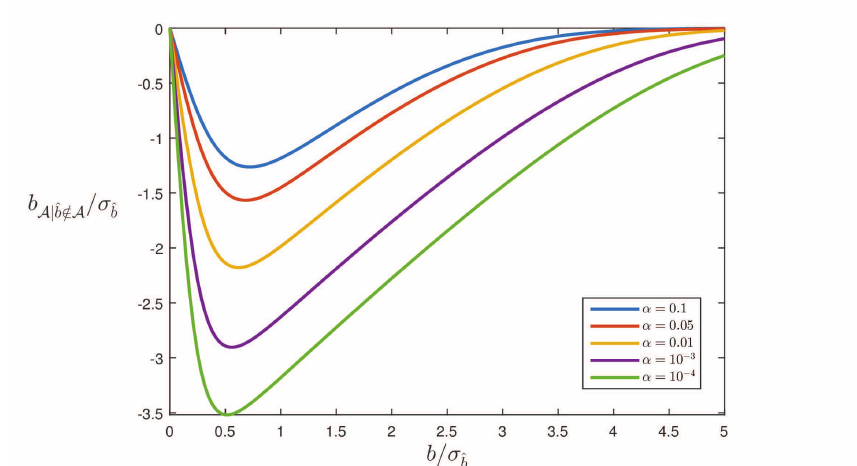
Figure 4. Bias, for correct rejection of H 0 , b